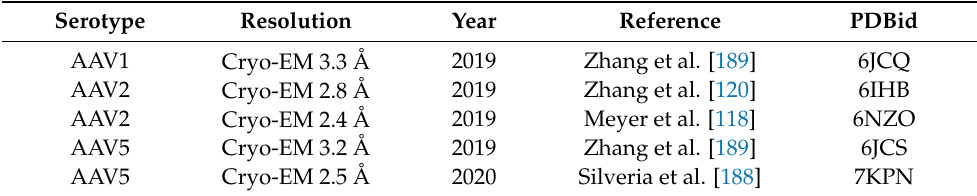
Table 3. Structures of AAV complexed with AAVR-receptor